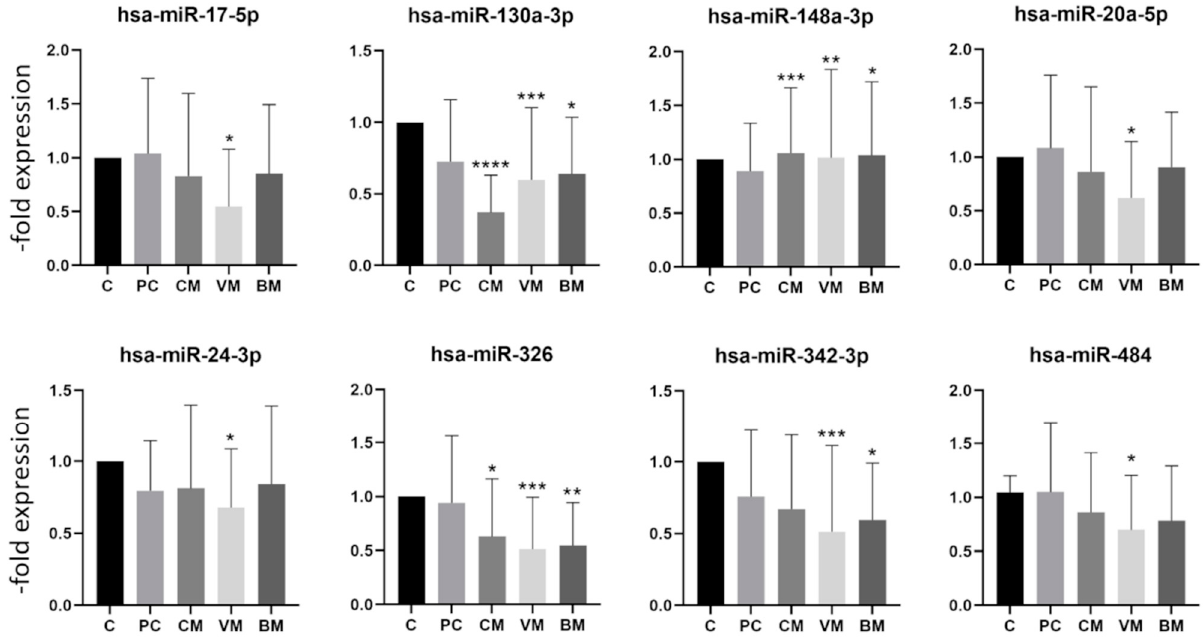
Figure 3. Expression levels of downregulated miRNA in exosomes from healthy controls and breast cancer patients with primary cancer (PC) and cerebral (CM), visceral (VC), or bone (BM) metastases. Data are presented as mean values of fold expression over the control group with standard deviations, * p < 0.05, ** p < 0.01, *** p < 0.001, **** p < 0.0001.